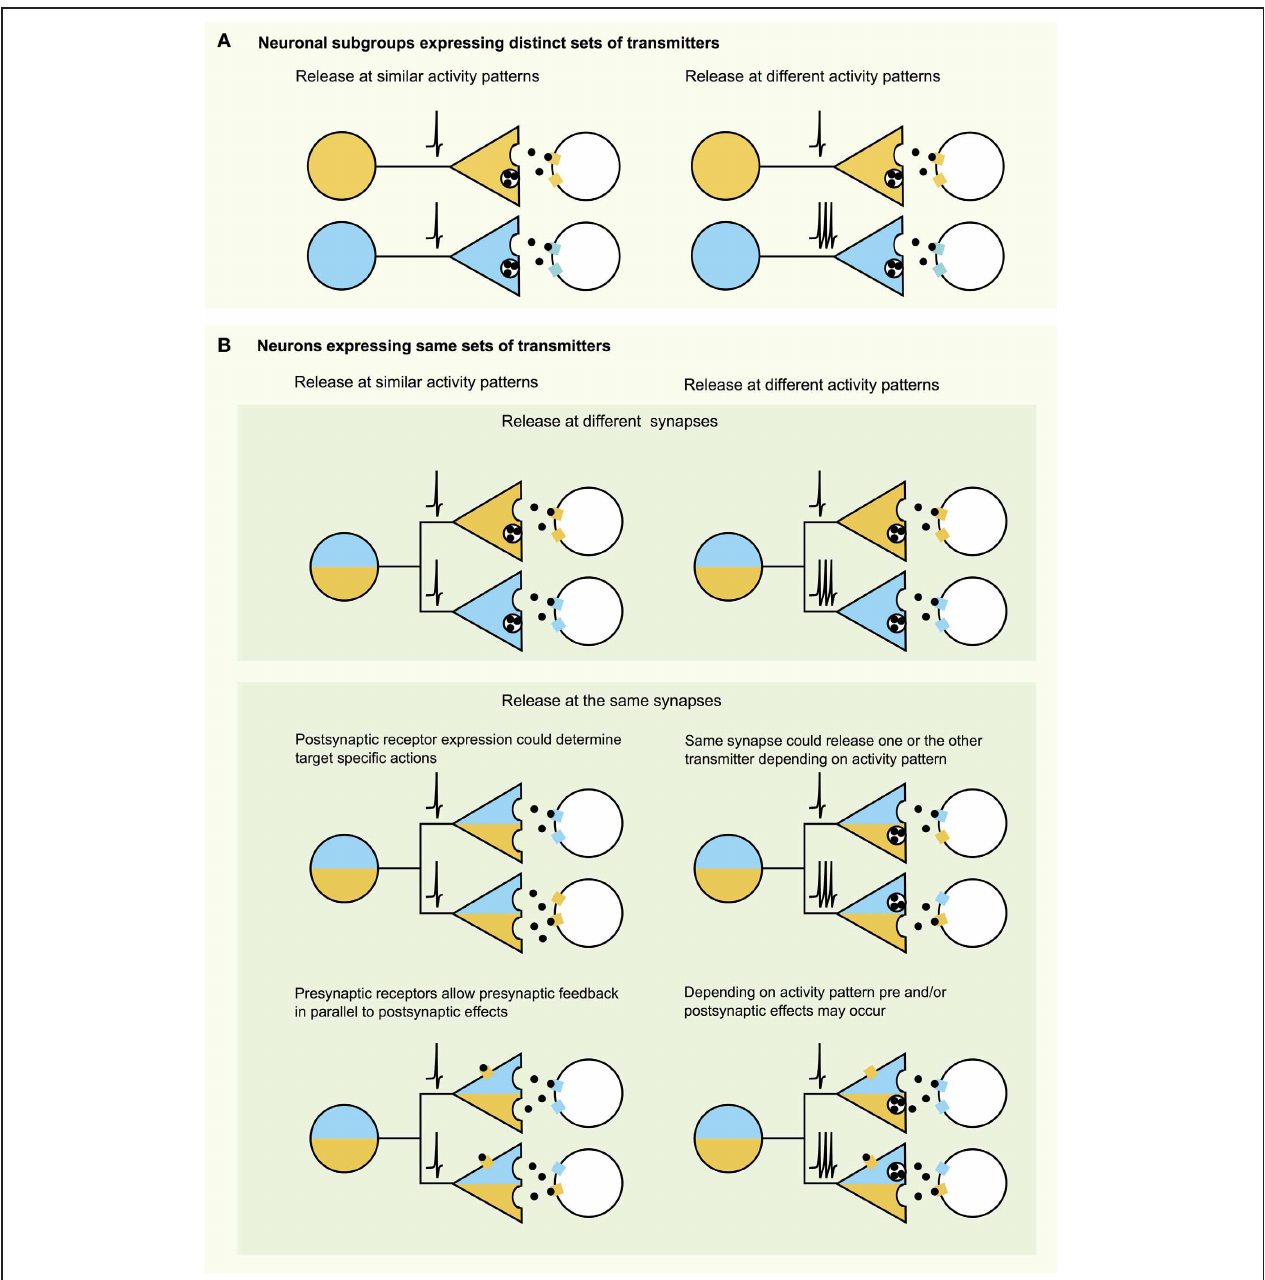
FIGURE 1 | Neurotransmission with multiple signaling molecules—a combinatorial analysis. (A) When a certain cell type expresses multiple transmitters, these may act differentially on specific targets with subgroups of neurons expressing subsets of transmitters and modulating different target areas. (B) However, multiple transmitters expressed in the same cell still may affect their targets differentially. As illustrated in the top panel transmitters